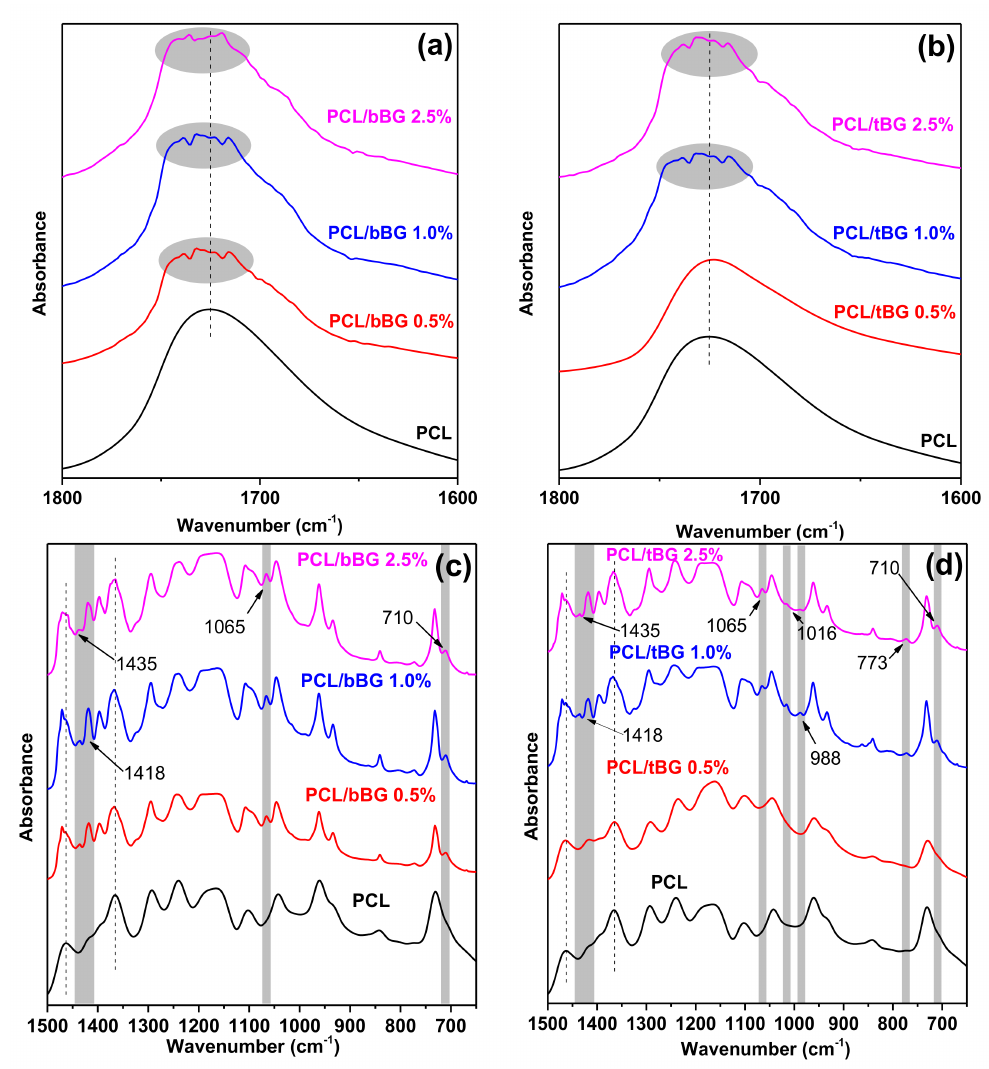
Figure 8. FTIR spectra of ( a ) PCL/bBG nanocomposites, ( b ) PCL/tBG nanocomposites and ( c , d ) zoomed in the region 1500–650 cm − 1